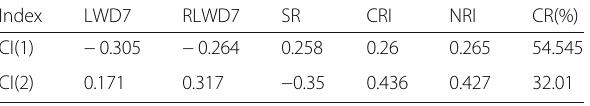
Table 1 Coefficients of comprehensive index CI(x) and contribution